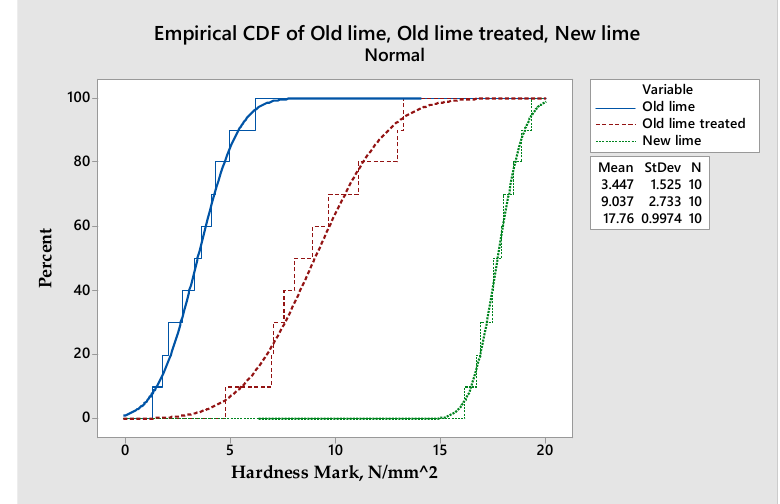
Figure 11. Mark hardness of 3 types of lime wood.